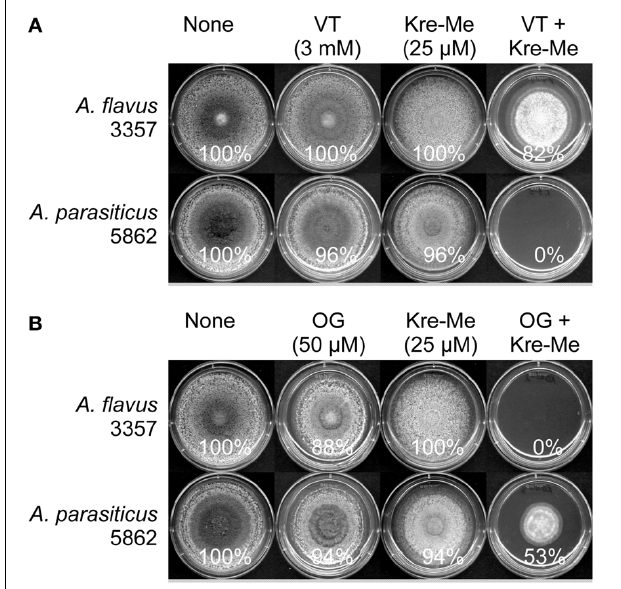
FIGURE 3 | Differential sensitivity of A. flavus 3357 and A. parasiticus 5862 to co-treatment of Kre-Me with VT or OG. (A) A. parasiticus 5862 was more sensitive to “Kre-Me + VT” compared to A. flavus 3357. (B) A. flavus 3357 showed higher sensitivity to “Kre-Me + OG” compared to A. parasiticus 5862. Results show differential sensitivity of each strain to different combinations of